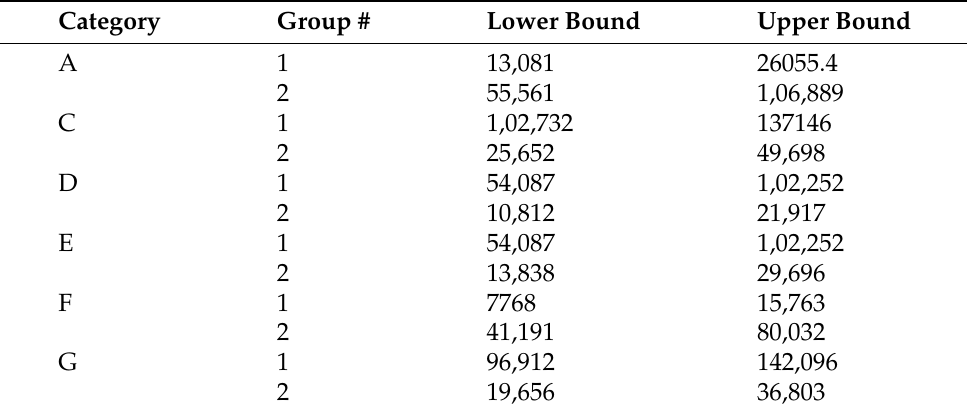
Table 18. Optimization of total medical benefit for each Category A,B,C,D,E,F and